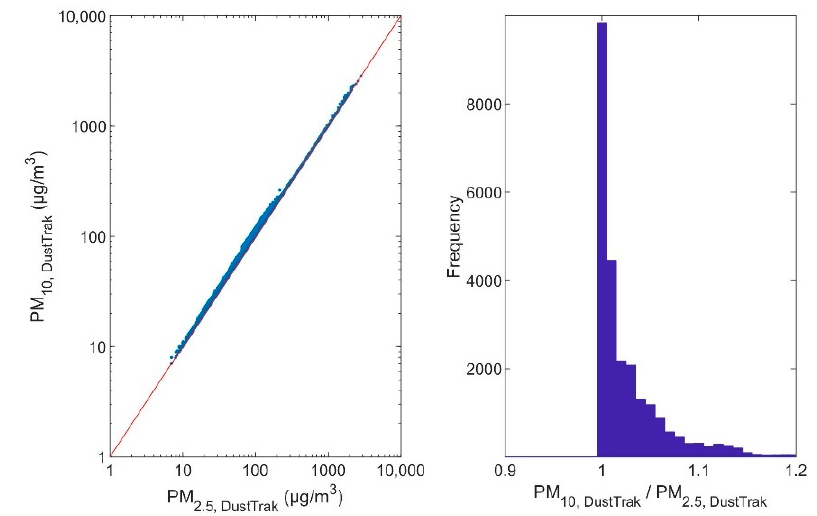
Figure 2. Comparison between the PM 10 and PM 2.5 concentrations measured with the DustTrak.